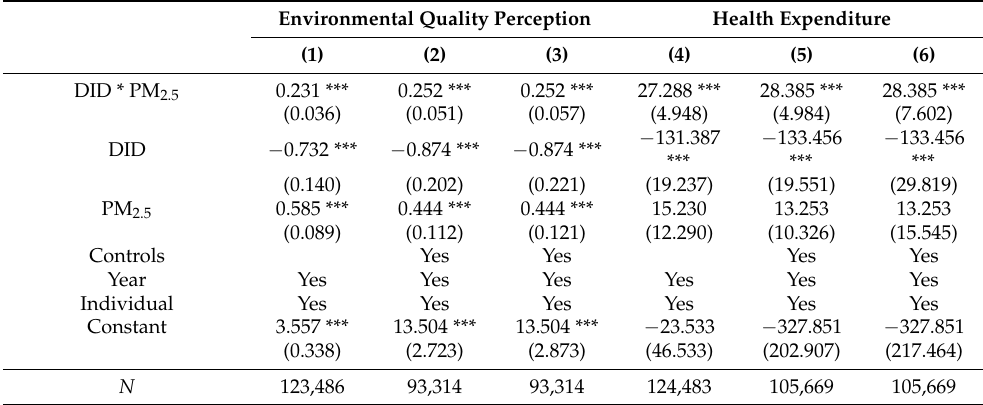
Table 6. Mechanism analysis—cognitive effect and avoidance